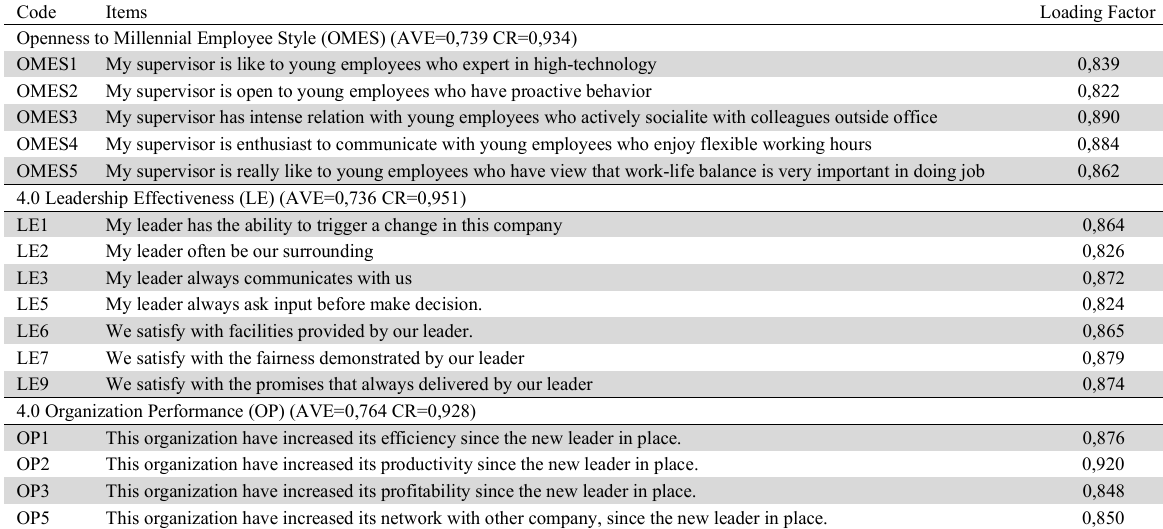
Outer loading and reliability assessment (AVE=average variance extracted)